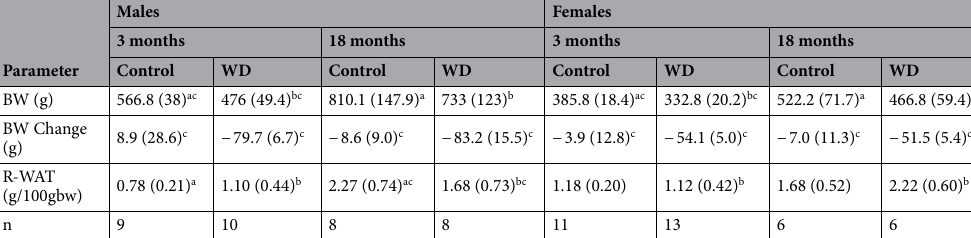
Table 1. Body weight (BW), body weight change, and R-WAT of 3- and 18-month-old control and male and female rats with water deprivation (WD). Values are expressed as means (SD). a Different between age in the control condition p < 0.05. b Different between age in the rats with water deprivation (WD) p < 0.05. c Different between control condition in the same age p < 0.05. Two-way ANOVA followed by Newman-Keuls post-test when variances were equal and Games-Howell when variances were